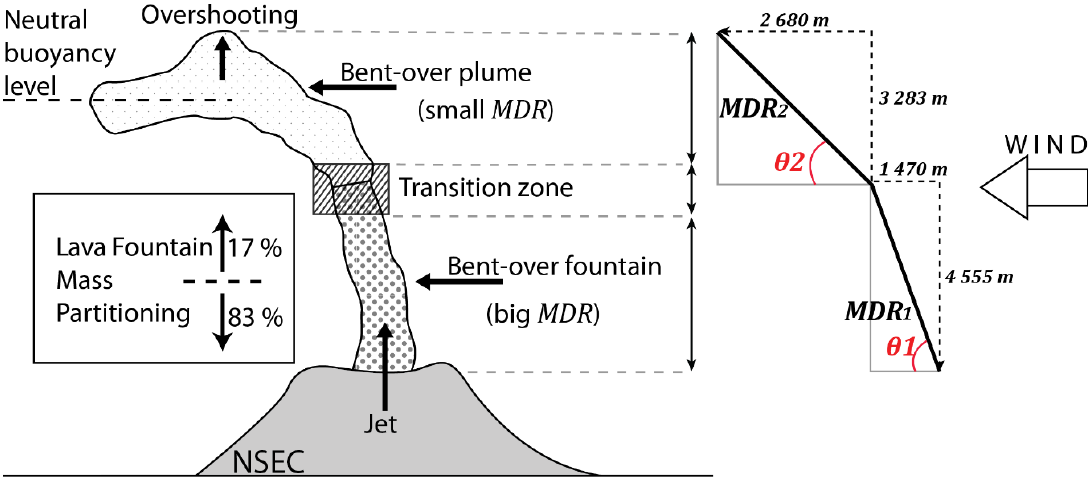
Figure 11. Wind e ff ect on the eruptive column of Etna 26 October 2013 lava Figure 11. Wind effect on the eruptive column of Etna 26 October 2013 lava fountain.